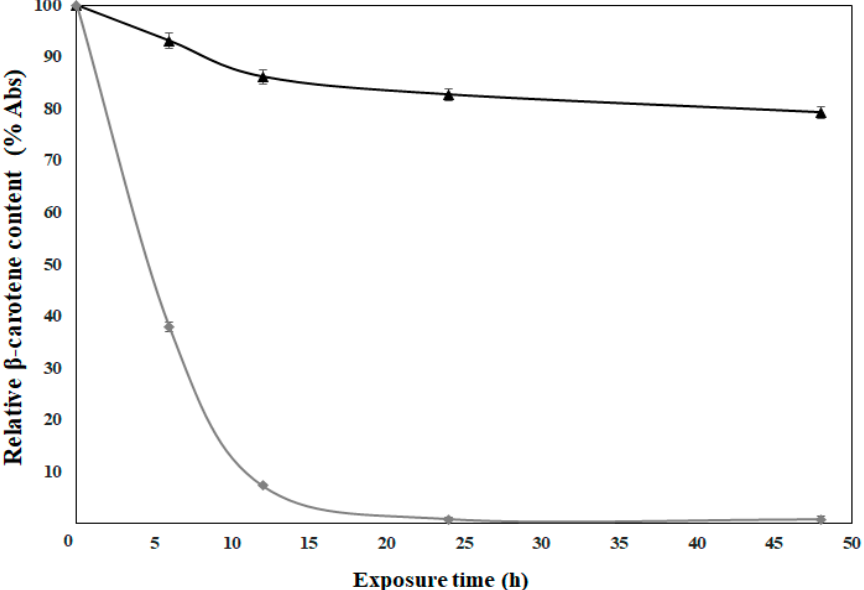
Figure 3. Photostability kinetics of the β -carotene ( ♦ ) and 70% HDPAF micro-nanofibers loaded with β -carotene ( ▲ ).